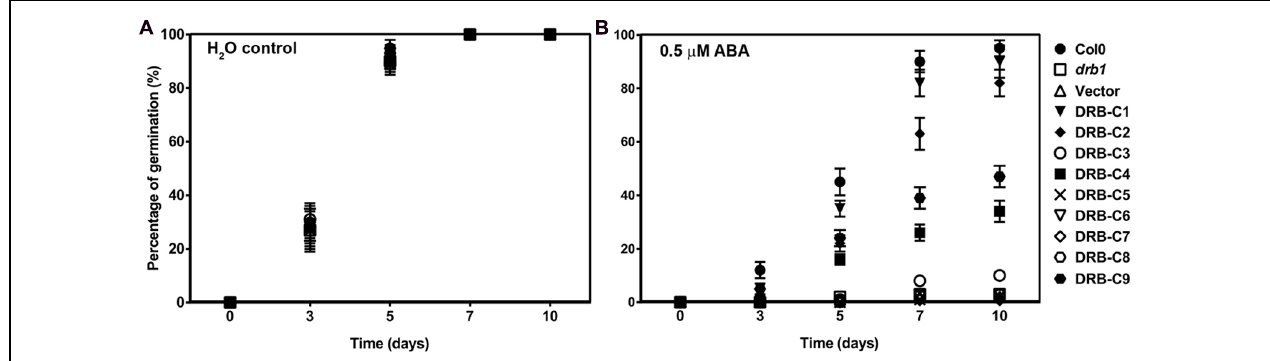
FIGURE 2 | Effects of exogenous ABA on wild-type, drb1 and transgenic plants. Seeds of wild-type, drb1 mutant and drb1 transgenic lines were germinated on filter paper saturated with either water (A) or 0.5 μ M ABA (B) . Seeds were incubated at 4 ◦ C for 48 h and then transferred to room temperature for assessment of their germination efficiency over a period of 10 days ( n > 100, ±